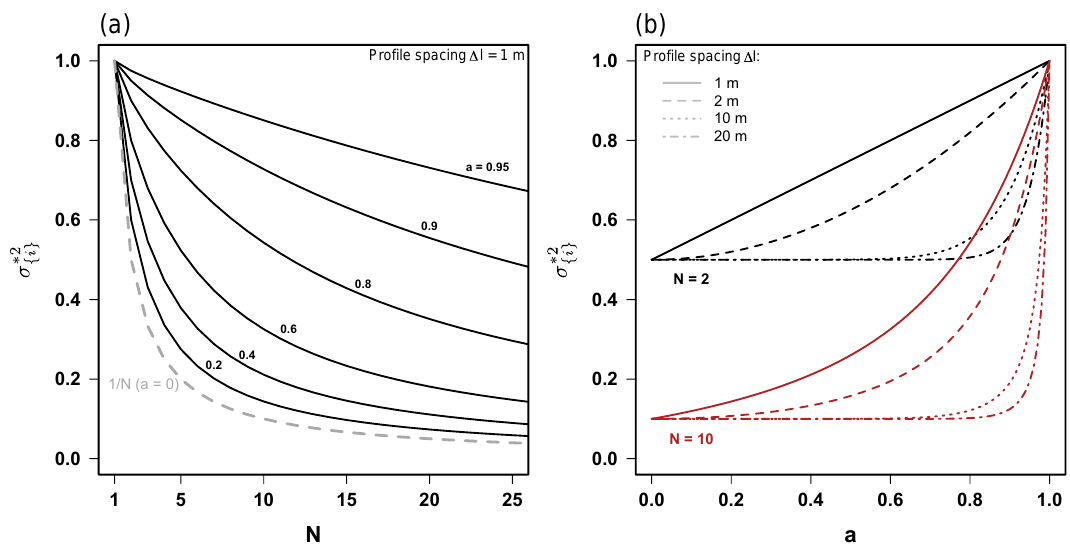
of a profile stack X { i } as a function of the number of profiles averaged for a profile Figure A2. (a) Relative effective noise variance σ ∗ 2 { i } spacing of (cid:49)(cid:96) = 1m and for different values of the autocorrelation parameter a . The limiting case of white noise ( a = 0) is indicated by a dashed line. (b) σ ∗ 2 { as a function of the autocorrelation parameter a for different numbers of averaged profiles and profile spacings. i }